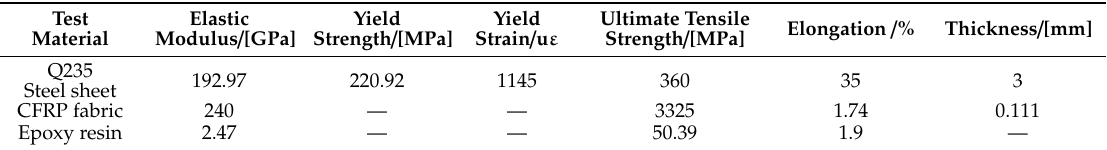
Table 1. Properties of the experimental materials.